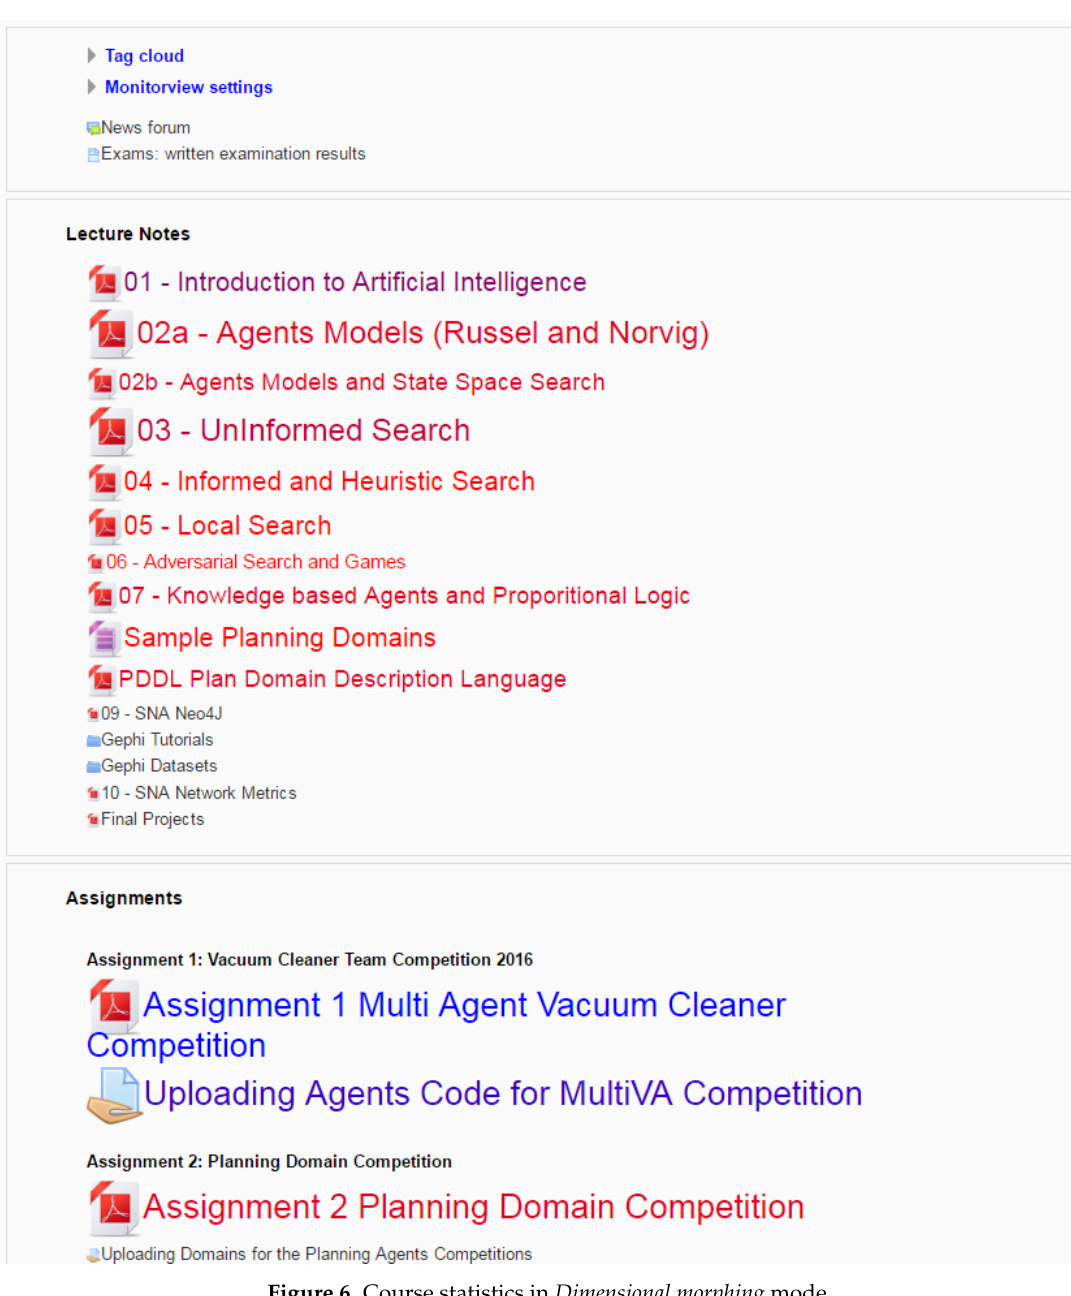
Figure 6. Course statistics in Dimensional morphing